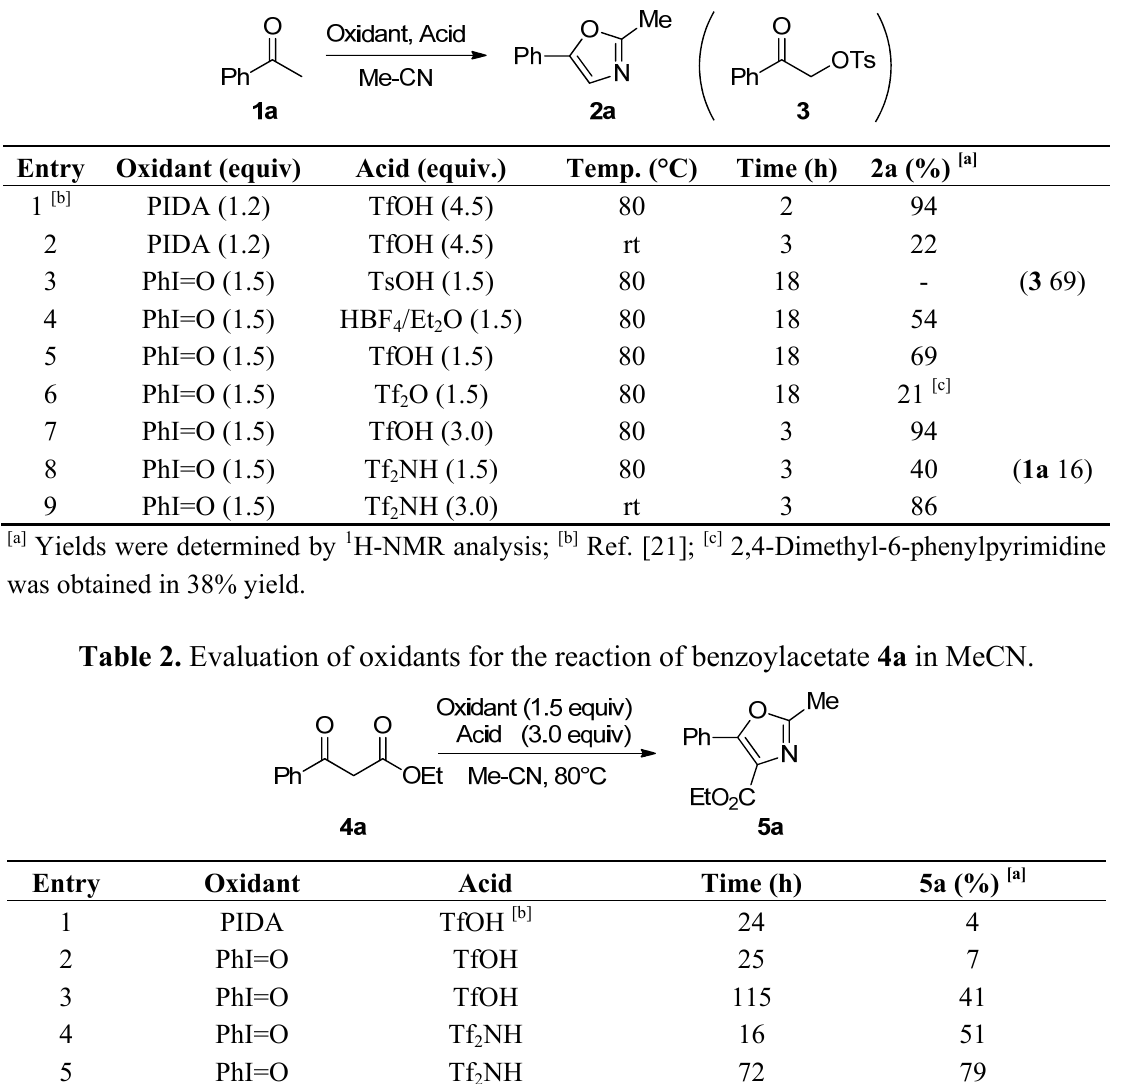
Table 1. Evaluation of oxidants for the reaction of acetophenone ( 1a ) in MeCN.